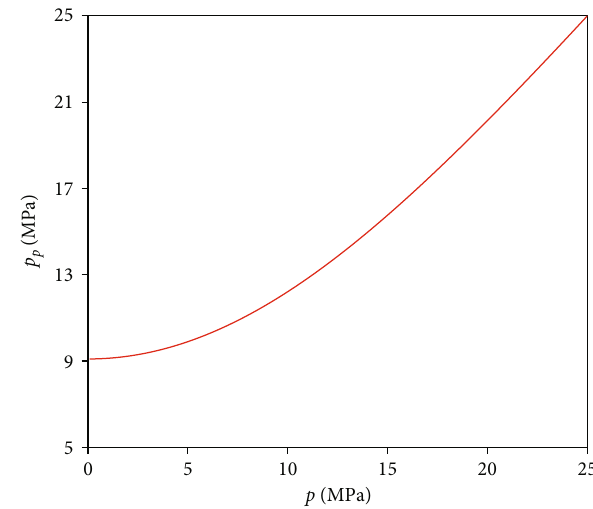
Figure 3: The relation curve of 1/ ð μ · C Þ vs. p for the normal pressure cases.